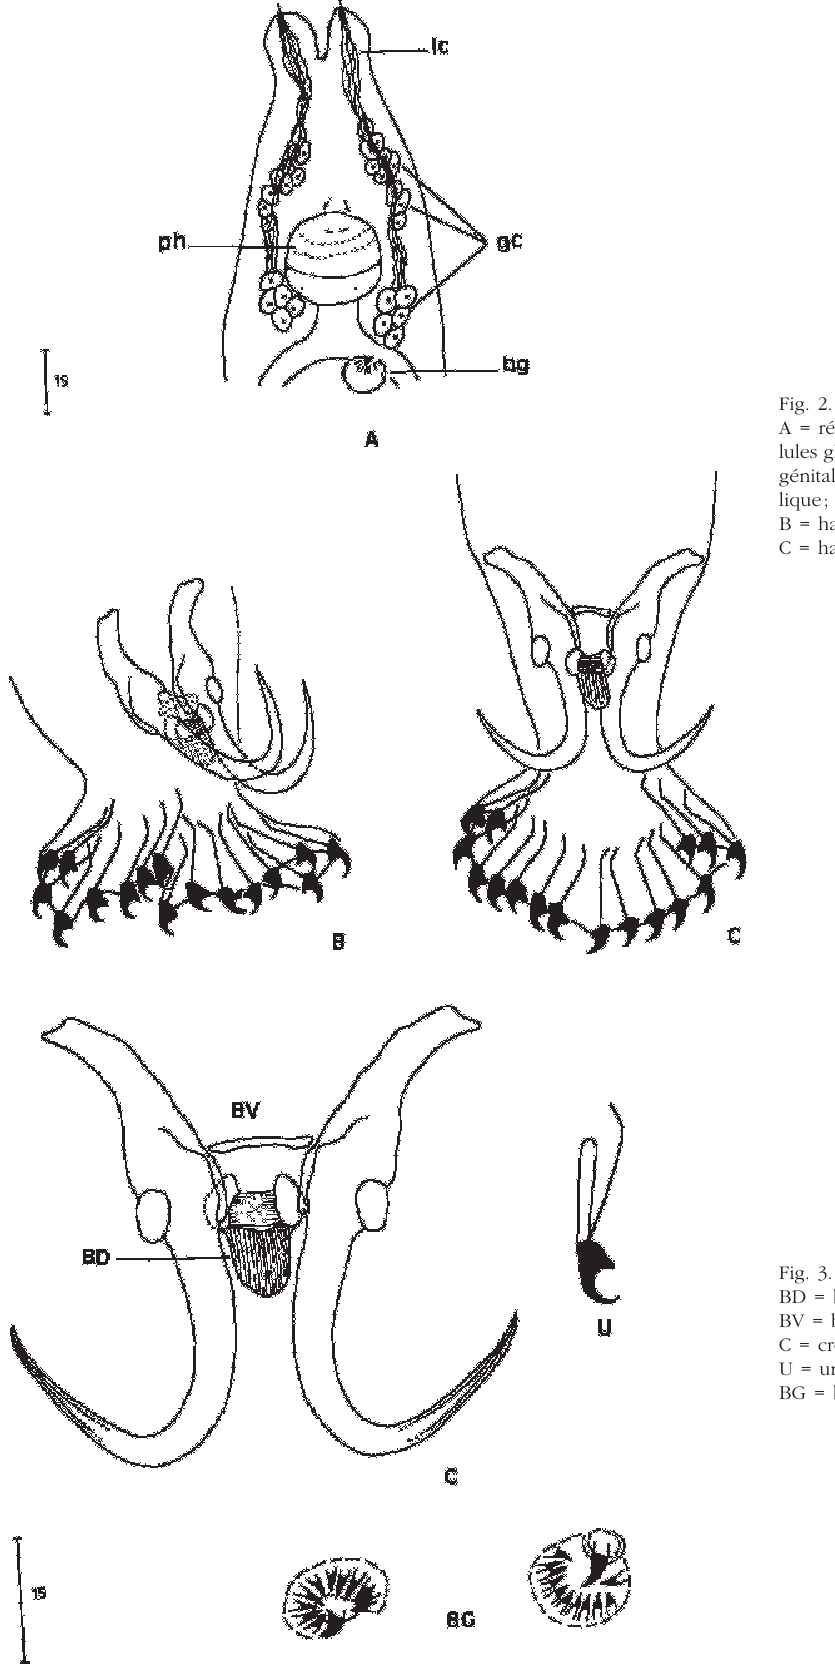
Fig. 2. – Gyrodactylus camerunensis n. sp. A = région antérieure avec la disposition des cel- lules glandulaires des lobes céphaliques (bg : bulbe génital; gc : glades céphaliques; lc : lobe cepha- lique; ph : pharynx); B = hapteur, vue latérale; C = hapteur, vue ventrale.